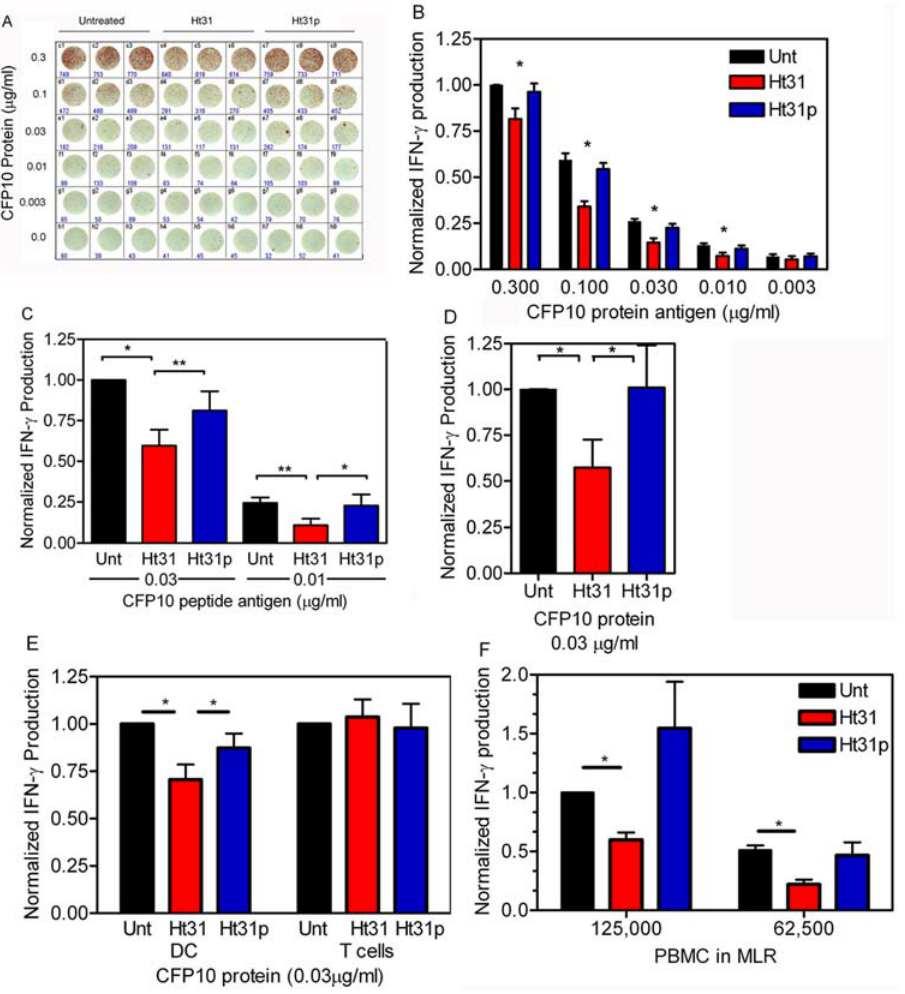
Figure 3. Anchored PKA is required for antigen presentation as assayed by IFN- c ELISPOT. A) One representative ELISPOT. Day 5 dendritic cells (iDC) were incubated without (Unt, black bars) or with Ht31 (red bars) or Ht31p (blue bars), and the indicated concentration of CFP10 protein (B) or CFP10 peptide antigen (C) for 1 hr at 37 u C. Antigen specific CD4 + clonal T cells were added and IFN- c production was assayed after 16 hours by ELISPOT. D) Allogeneic day 5 dendritic cells (iDC) were incubated without (Unt, black bars) or with Ht31 (red bars) or Ht31p (blue bars) for